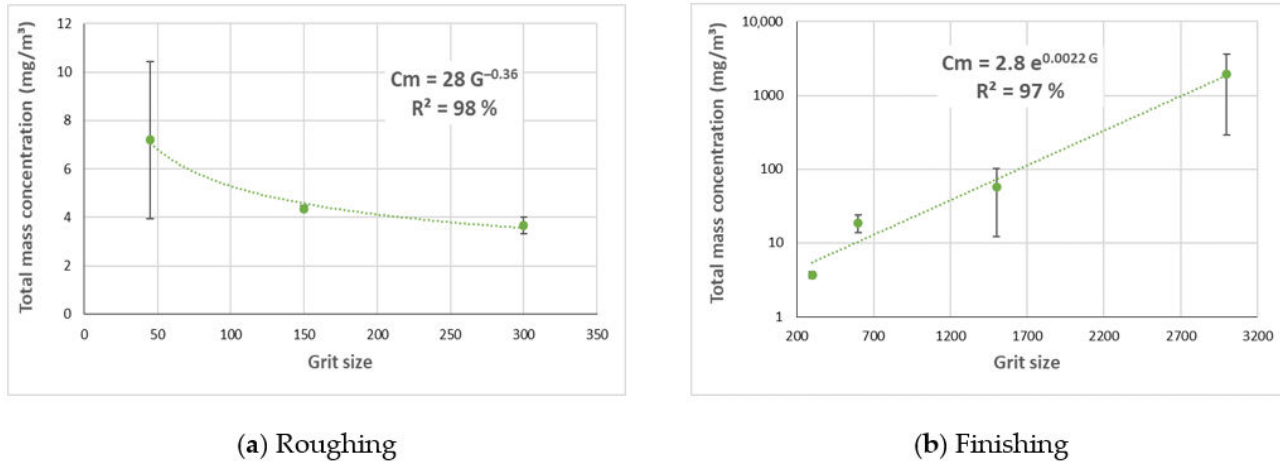
Figure 15. Total mass concentration of UFP while grinding white granite in two phases for different grit sizes; ( a ) roughing phase, ( b ) finishing phase (Vs = 3500 rpm; f = 1000